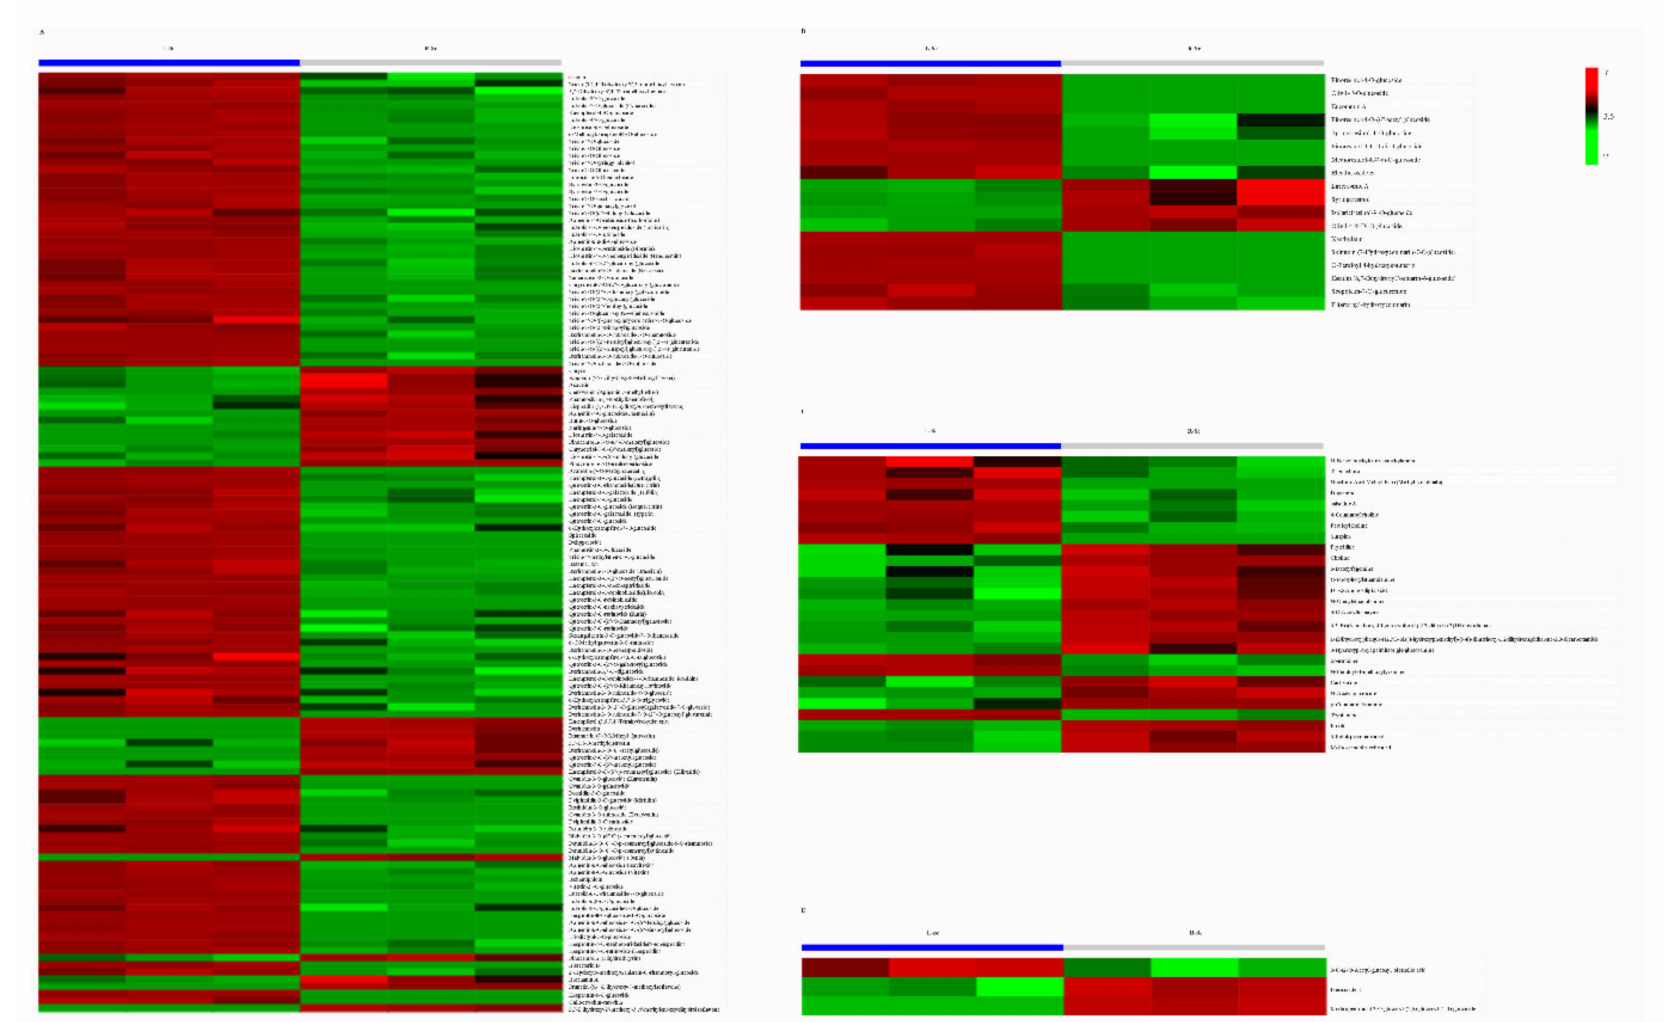
Figure 5. Heatmap of the differentially accumulated metabolites in potential antioxidant components between L-Sc and R-Sc. ( A ) Flavonoids, ( B ) lignans and coumarins, ( C ) alkaloids, and ( D )